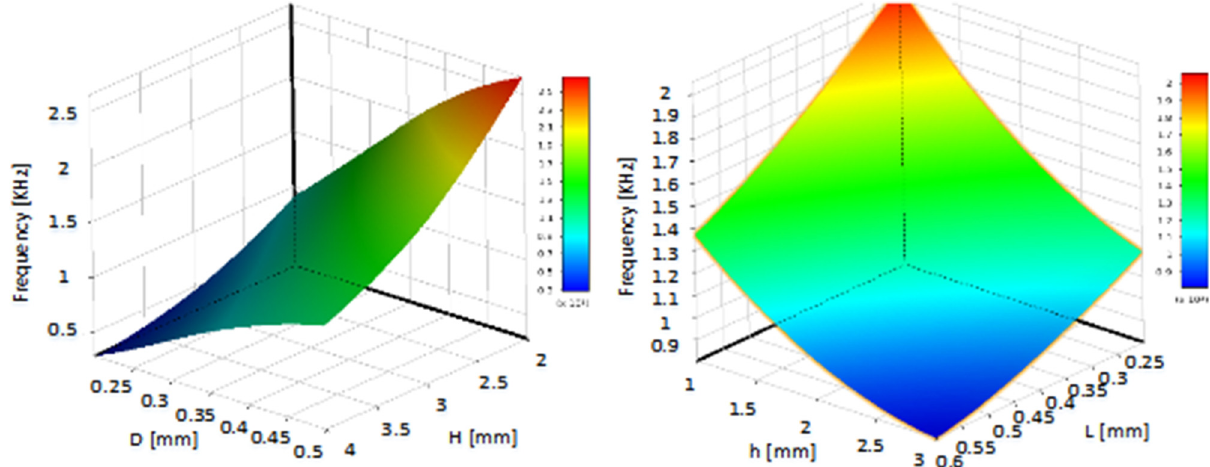
Fig. 7. The relationship between parameters (H, h, R, L) and natural frequency.